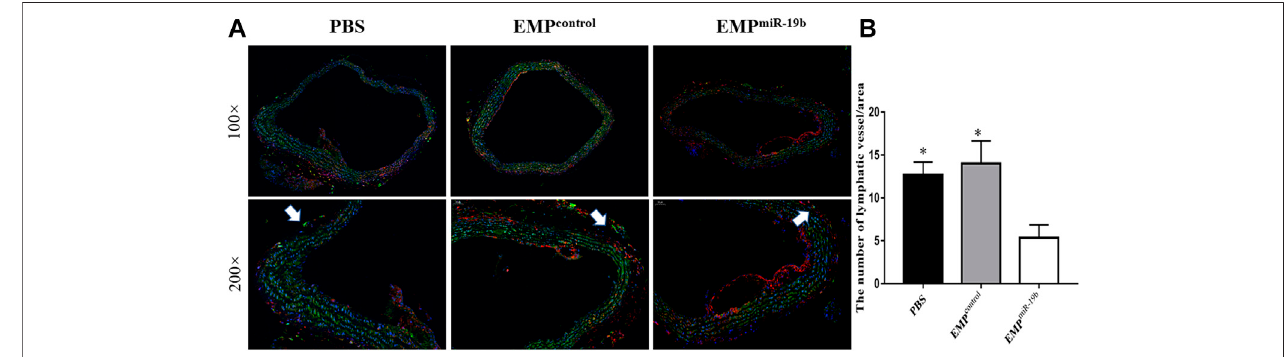
FIGURE 4 | EMP miR-19b limits lymphatic network distribution along atherosclerotic arteries. (A) Representative immuno fl uorescence staining images of atherosclerotic arteries from high-fat diet-fed ApoE -/- mice intravenously injected with PBS, EMP control , or EMP miR-19b for 8 weeks. In the images, green fl uorescence representsLYVE1,arelativelyspeci fi cmarkeroflymphaticvessels,whilered fl uorescencerepresentsCD68.LYVE1 + /CD68 - tubularstructuresareidenti fi edaslymphatic vessels. (B) Quantitative analysis of the results shown in (A) . * p < 0.05 compared with EMP miR-19b group, n = 7 – 8 per